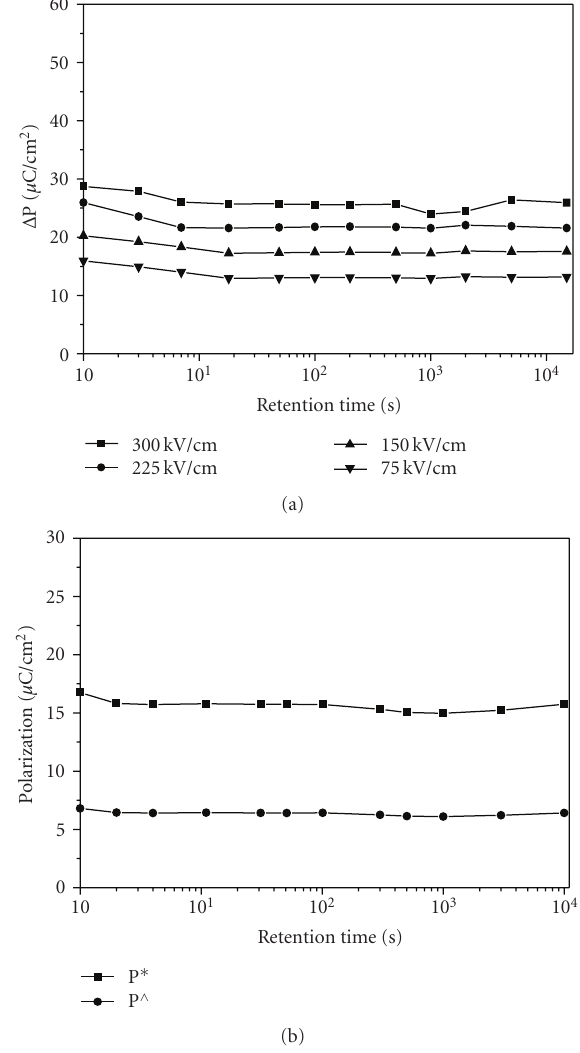
Figure 7: (a) Long-time retention characteristics at various electric fields (75 to 300 kV/cm), and (b) the long-time retention character- istics (P ∗ and P ∧ ) measured at an applied electric field of 150 kV/cm for CBTi144 thin film deposited on (100) Pt/Ti/SiO 2 /Si substrate at 700 ◦ C for 2